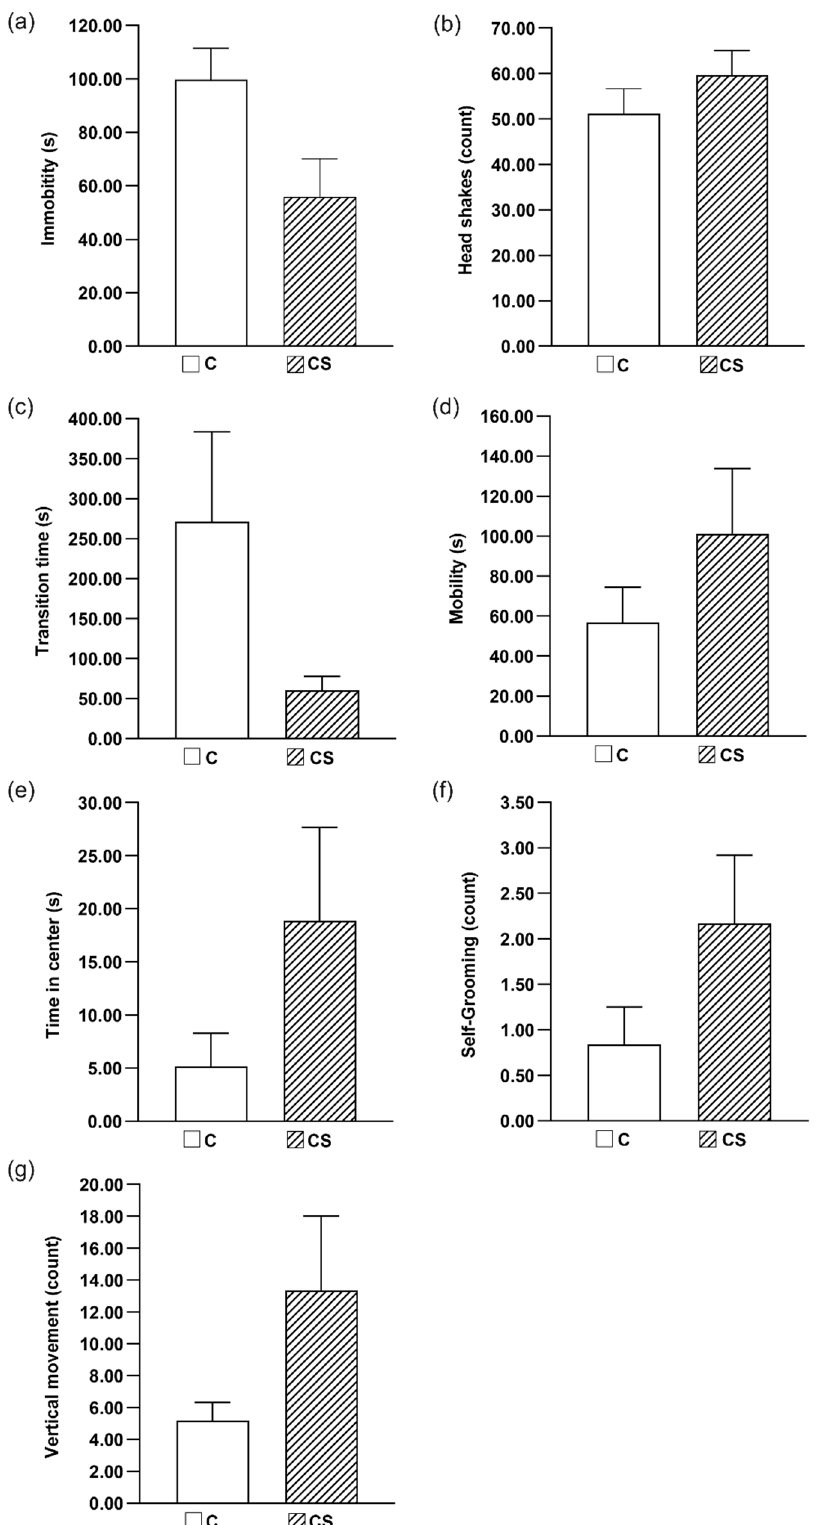
Figure 4. The battery of behavioral tests: ( a ) Porsolt test: mean time of immobility, ( b ) Porsolt test: mean number of head shaking, ( c ) classical labyrinth test: mean time transition through the labyrinth, ( d ) open field test (OFT): mean time of mobility, ( e ) OFT: mean time in center, ( f ) OFT: mean number of self-grooming (facial wash, body cleaning, genital grooming), ( g ) OFT: mean number of vertical movement. C = control group, CS = group with 12.5 g of chicory / kg of exp. diet. Number of animals in all groups n = 6.